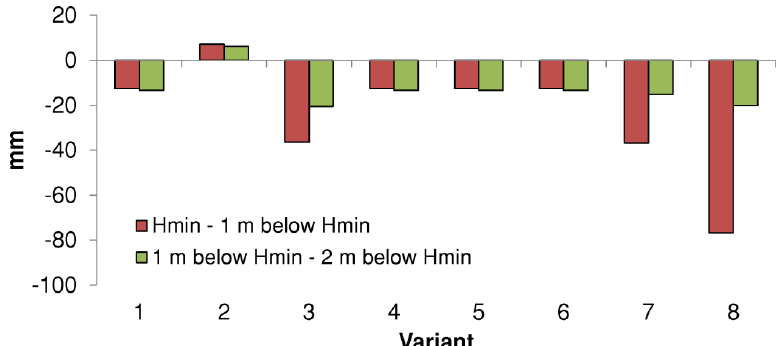
Figure 7. Change in the water storage characteristics of the modified variants compared to variant 0.